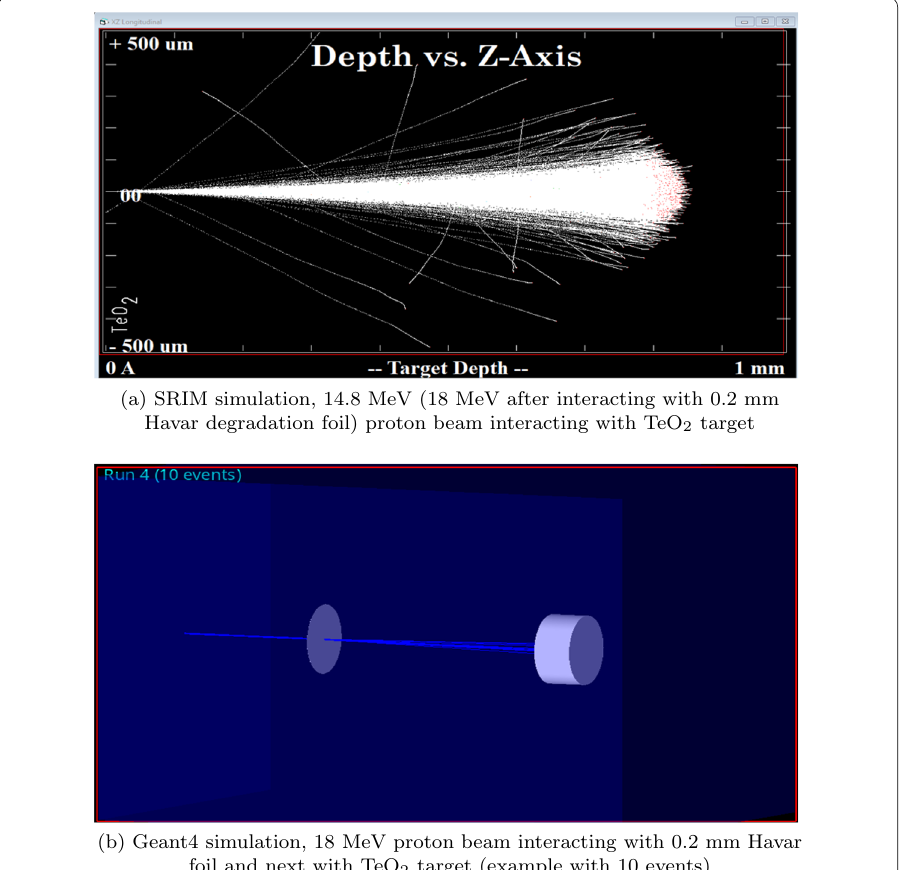
Fig. 4 Simulated IBA 18/9 cyclotron geometries. a A simple SRIM/TRIM model and b a complex geometry of the cyclotron irradiation system created in